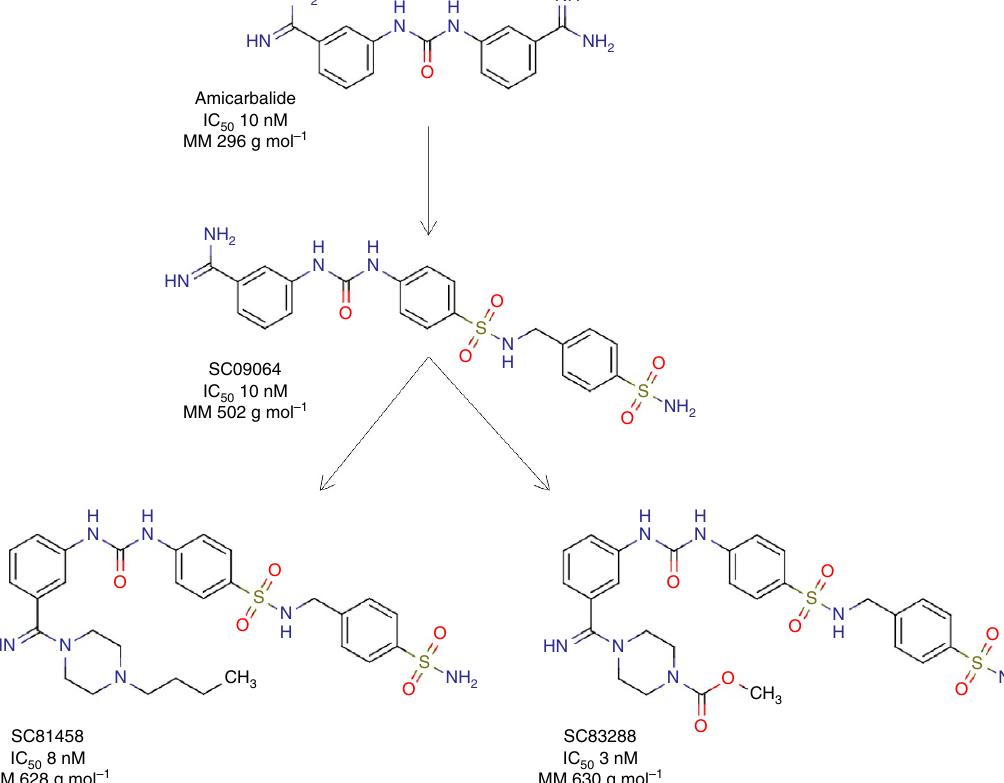
Figure 1 NATURE COMMUNICATIONS|8:15273|DOI: